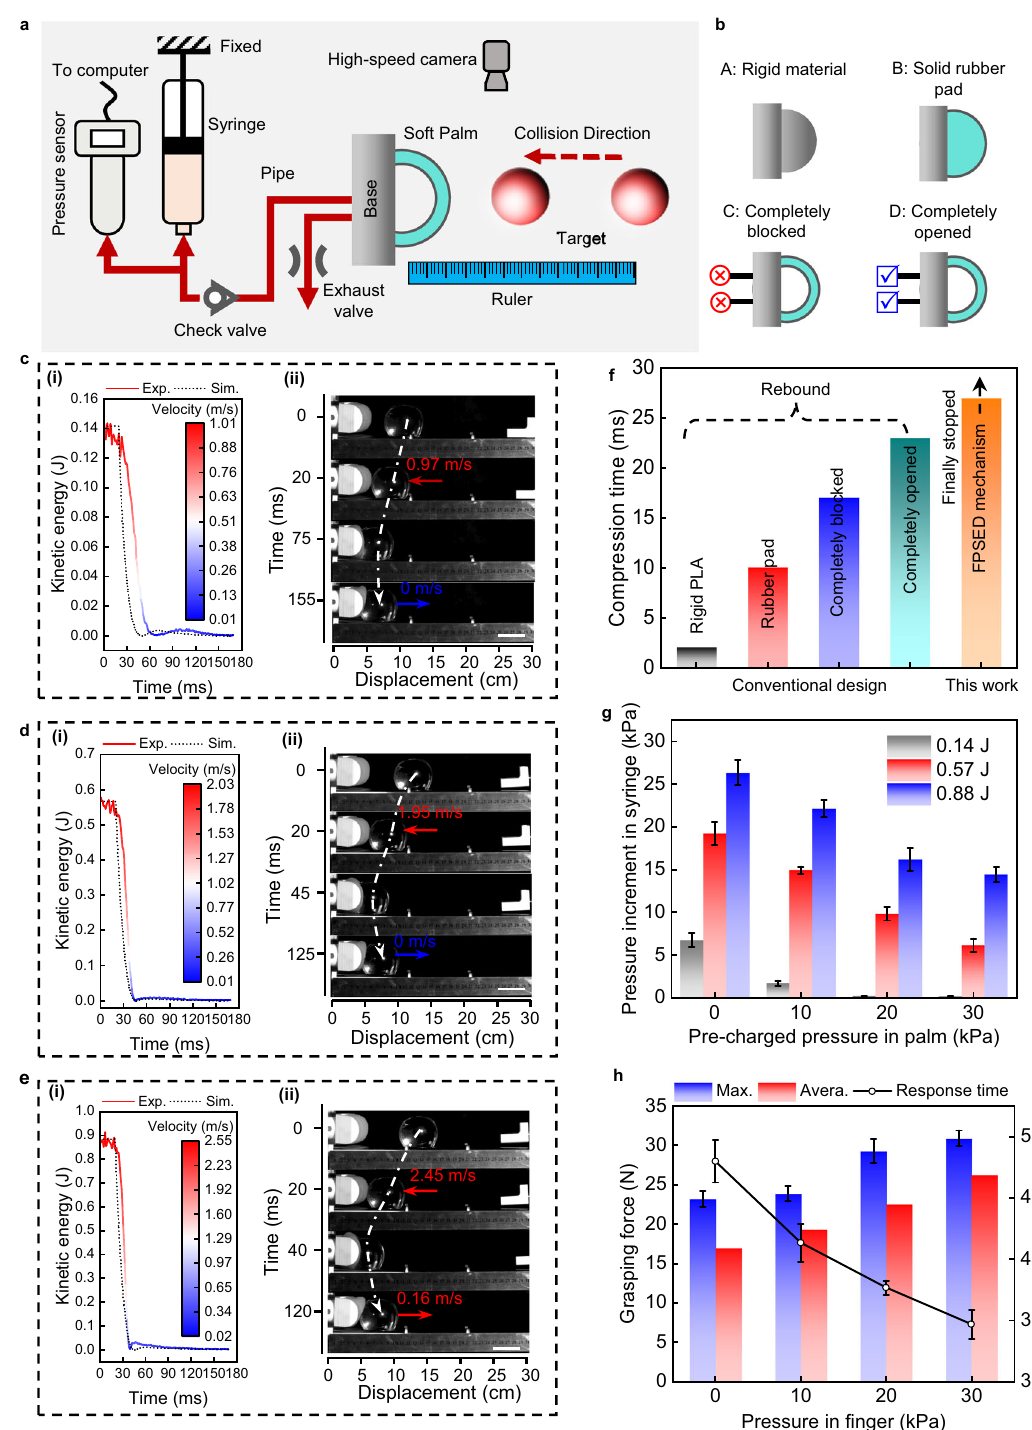
Fig. 3 | Palm characterizations. a Schematic diagram of the experimental set-up forcollisiontests. b Fourtypicalpalmdesigns.DesignAisarigidpalmprintedwith polylactic acid; design B is a solid silicone rubber pad; designs C and D are both hollow soft airbags. The difference between them is that the vents of design C are completely closed, while design D is always open to the atmosphere. c – e Experimental results of the proposed FPSED mechanism at three collision kineticenergies0.14J( c ),0.57J( d ),and0.88J( e ).Leftimage(i)isthekineticenergy dissipationcurveoftheball,wherethecolormaprepresentsthevelocitydecayofa ball.Thepictureontheright(ii)showsthepositionoftheball-palmateachkeytime point. f Comparison of the collision compression time between the conventional